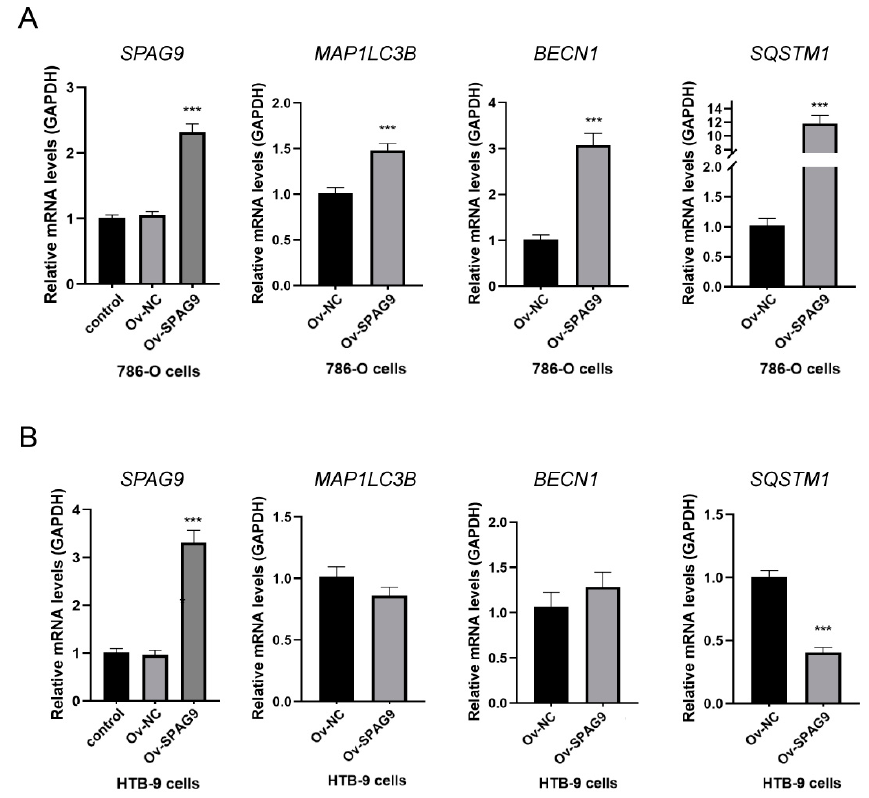
Figure 3. Effects of SPAG9 overexpression on autophagy-related genes in ( A ) 786-O cells and ( B ) HTB-9 cells. Control: untreated cells; Ov-NC: cells transfected with control plasmids; Ov-SPAG9: cells transfected with SPAG9 plasmids. *** p value < 0.001.